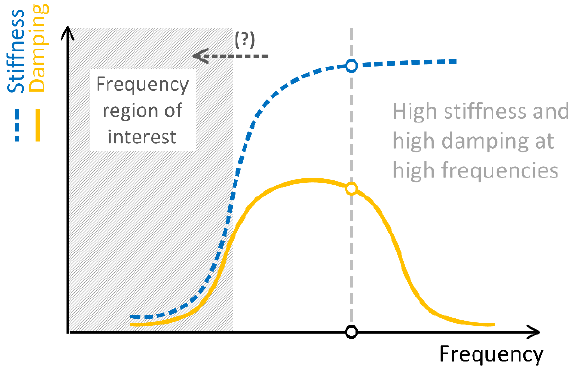
Figure 3. Frequency with damping performance of materials for vibration and impact isolation.